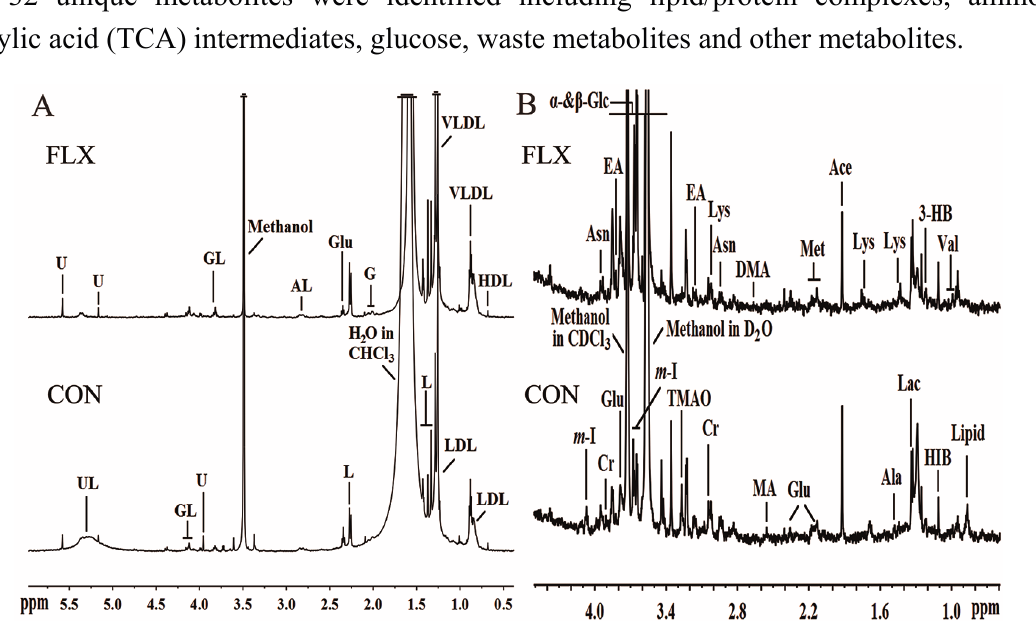
Figure 3. Representative 600-MHz 1 H NMR spectra of lipid ( A ) and aqueous ( B ) phases of cellular extracts obtained from the control group (CON) and fluoxetine-treated group (FLX). Abbreviations: 3-HB, 3-hydroxybutyrate; Ace, acetate; AL, albumin lysyl; Ala,